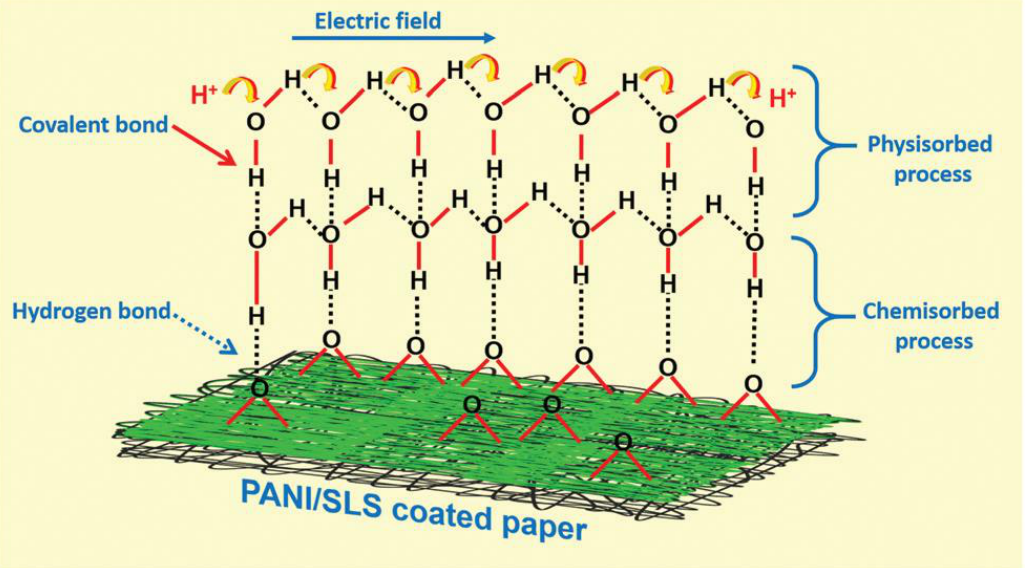
Figure 13. Schematic diagram depicting the sensing mechanism of the polyaniline (PANI)/SLS-X coated paper-based humidity sensor. Reprinted from [263]. Published 2022 by RSC as open